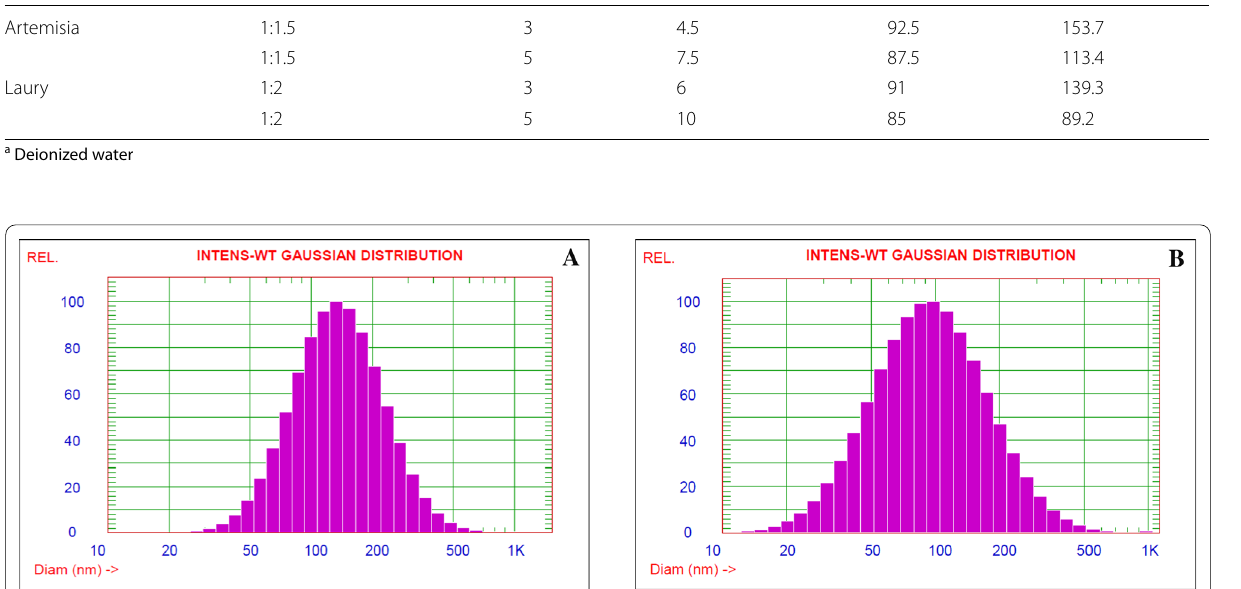
Fig. 2 Particle size of Artemisia essential oil nanoemulsion: A with size 153.7 nm and B with size 113.4 nm at 3 and 5% concentrations,